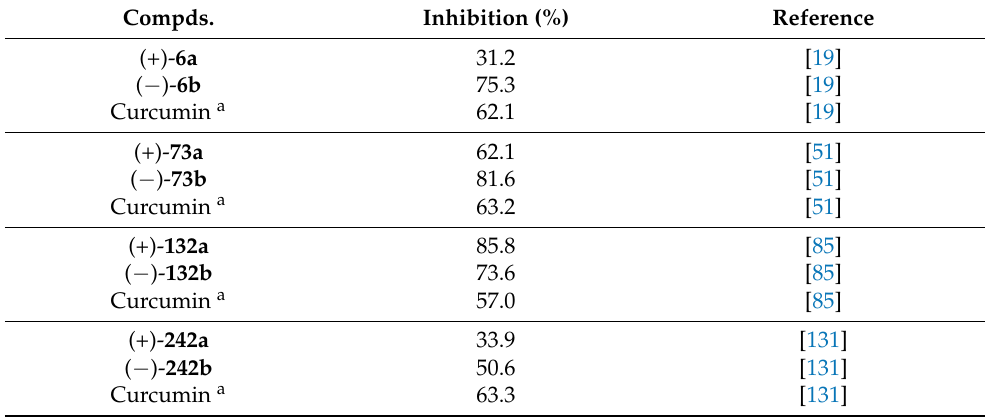
Table 10. A β aggregation inhibition of enantiomers.